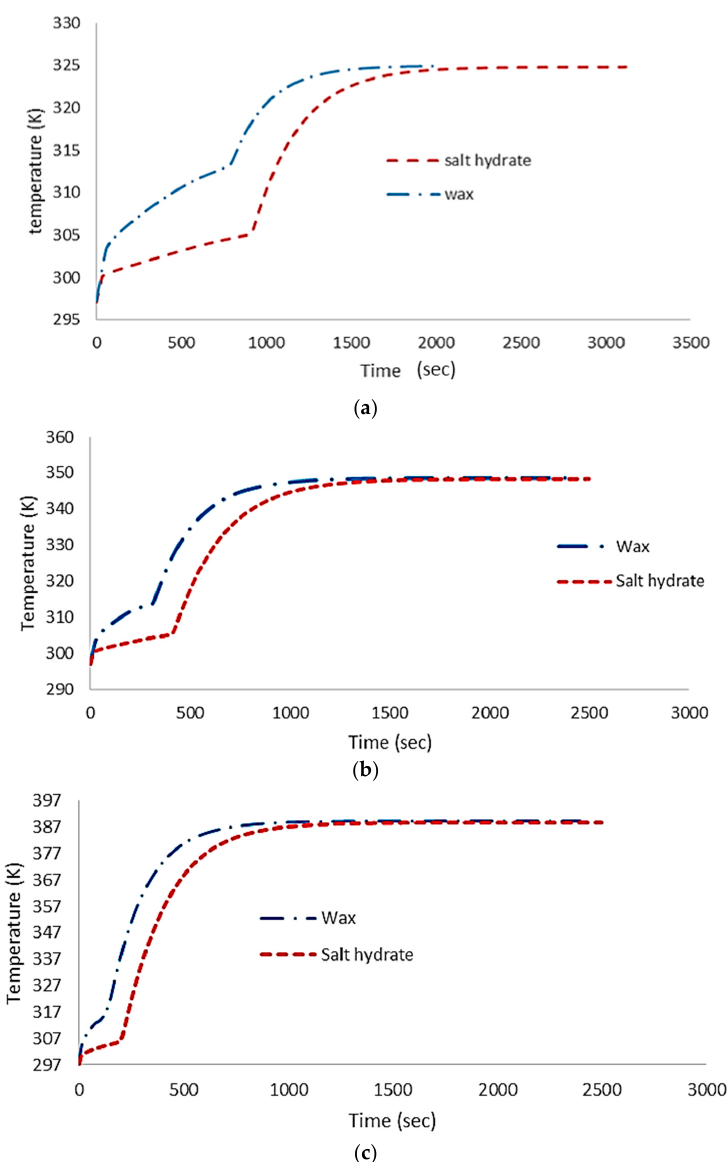
Figure 9. Transient variation of the temperature of the heat sink under ( a ) 1250 W/m 2 ; ( b ) 2500 W/m 2 ; ( c ) 5000 W/m 2 .